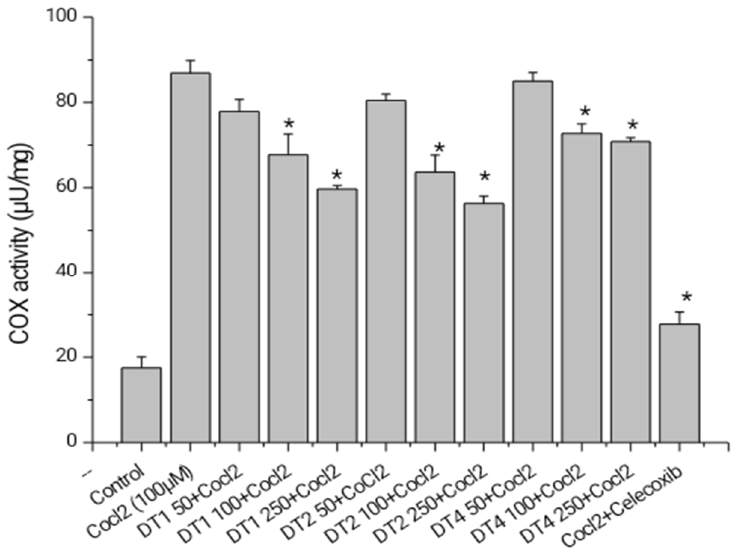
Figure 7. Graphical presentation represents COX inhibition activity in CoCl 2 (100µM) exposed U87 MG cells after treatment with tea plants extracts (DT01, DT02, and DT04) at 50, 100, and 250 µg/mL for 24 h. Here, celecoxib was used at 100 µM. Values are expressed as mean ± SEM, n = 3. * Significant difference ( p < 0.05) compared to only CoCl 2 group.